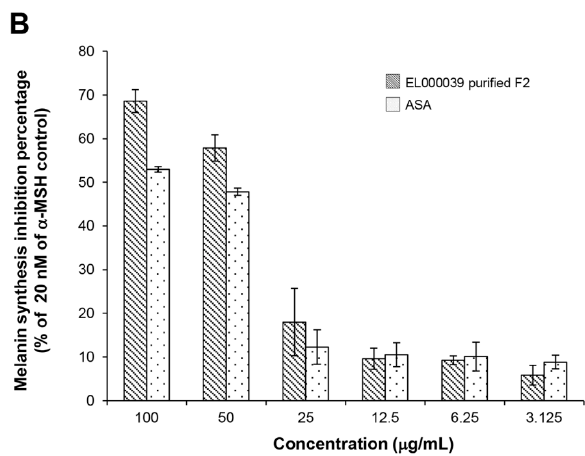
Figure 6. Effects of ELF000039 purified F2 ((3 R )-5-hydroxymellein) on melanin synthesis in B16F1 cells. Cells were treated with different concentrations of (3 R )-5-hydroxymellein or ASA under 20 nM of α -MSH. ( A ) Melanin content percentage was expressed and the melanin content of cells without α -MSH was considered 100%. DMSO was used as a negative control; ( B ) Melanin synthesis inhibition of (3 R )-5-hydroxymellein and ASA under 20 nM of α -MSH compared to DMSO. Data shown are the means ± SD, n = 3.